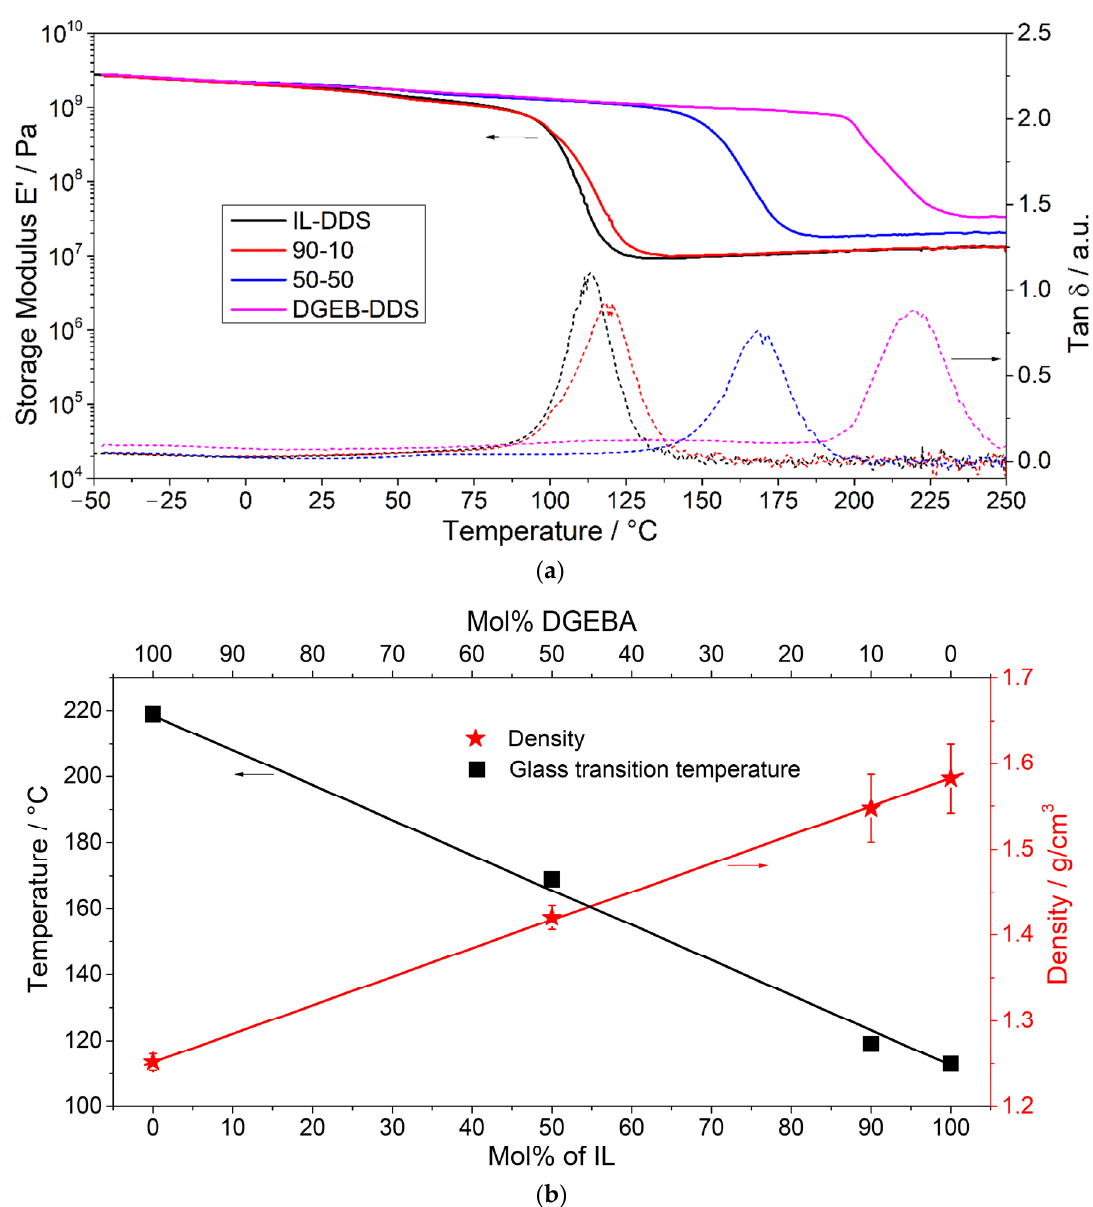
Figure 6. ( a ) Storage modulus (solid lines) and tan δ (dashed lines) of the copolymers. ( b ) T g ( ) and density ( ★ ) of the copolymers in dependence of the molar fractions of epoxy monomers.